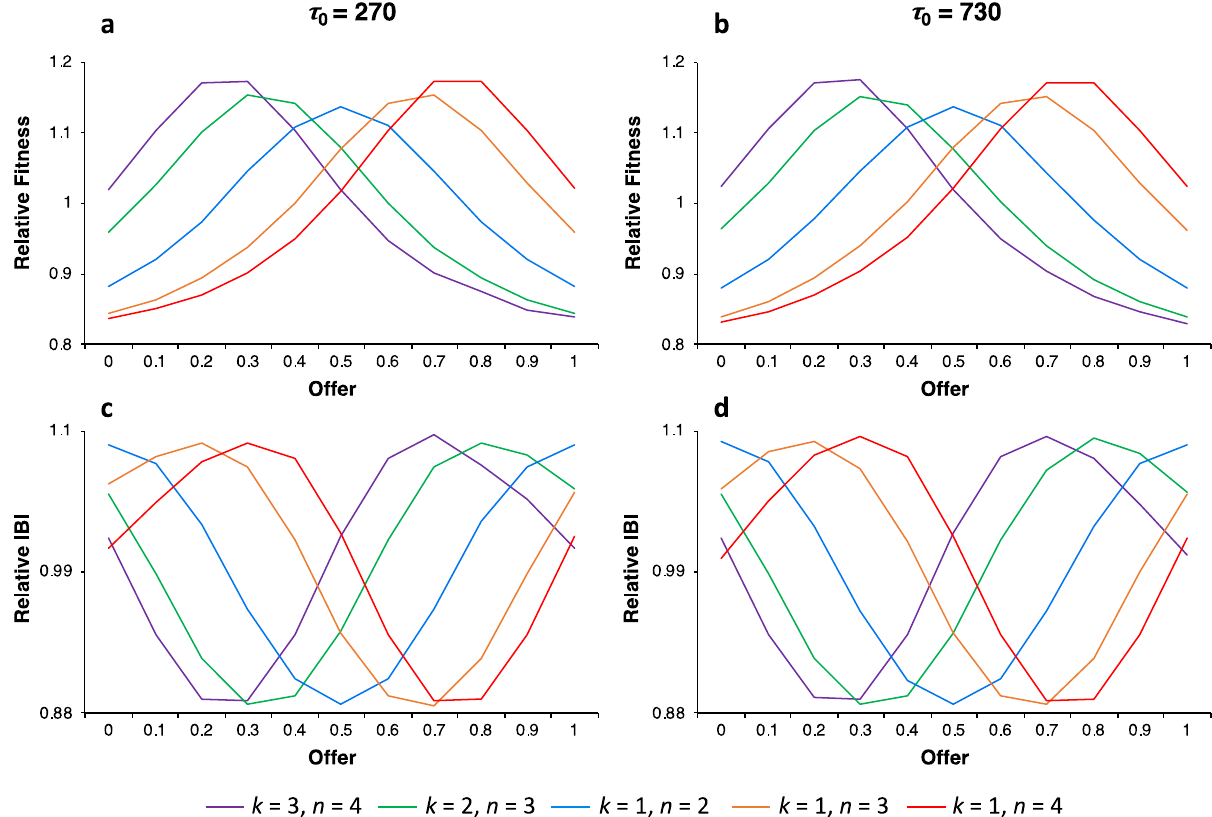
Figure 3. The effects of accumulated resource variation on the relative fitness and the relative IBIs of offer strategies for the five DG k , n for c = 0.01 and γ = 0.9. Plots of the relative fitness values for offer strategies are nearly the same for τ = 270 ( a ) and τ = 730 ( b ). A similar effect occurs for the relative IBIs in ( c ) when compared to ( d